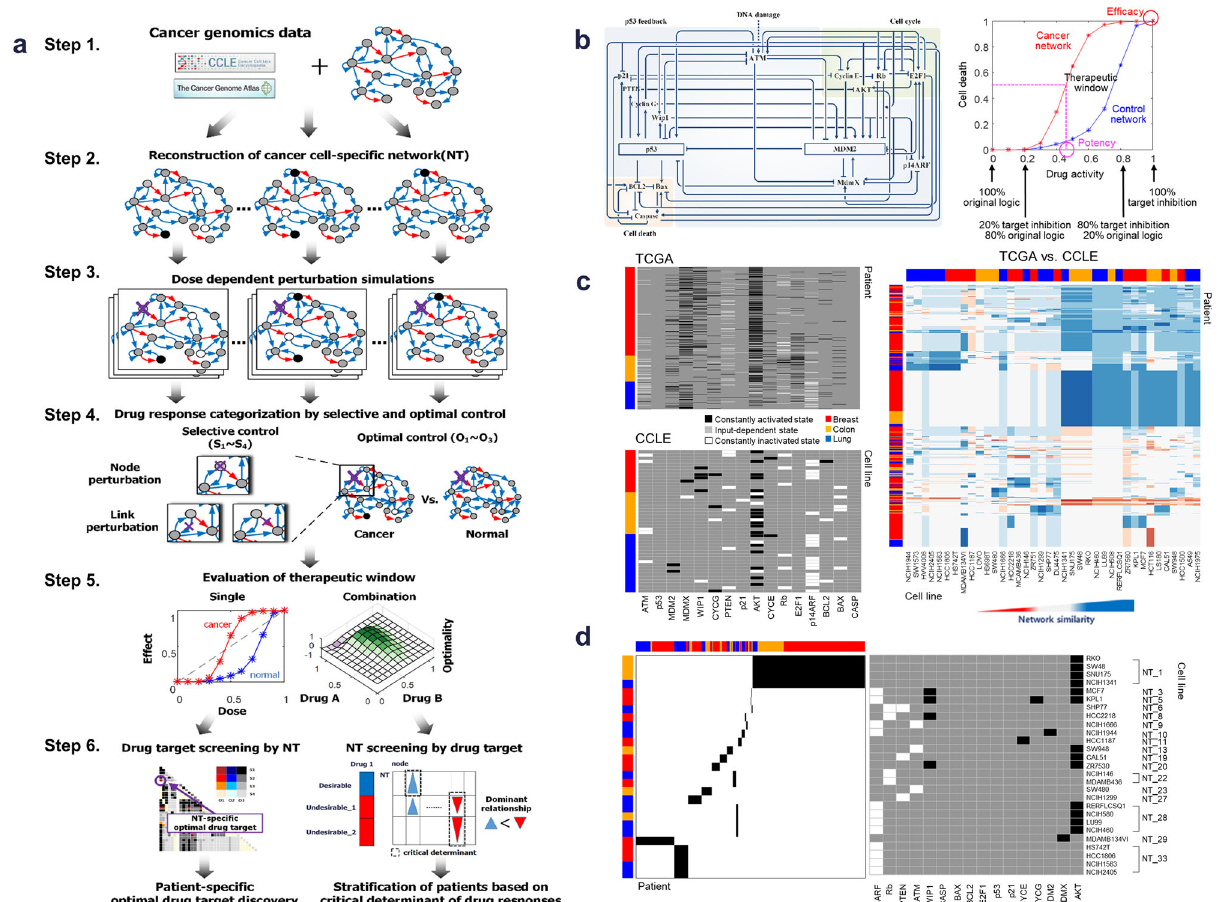
Fig. 1 Network dynamics-based estimation of therapeutic window and application to p53 network. a Overview of the 6 steps in application of network dynamics-based estimation of therapeutic window for drug-target discovery and strati fi cation of patients. b Dose – response curves (right) were obtained from simulations of dose-dependent perturbations in the p53 regulatory network (left). Red and blue graphs denote dose – response curves of cancer and control network, respectively. Ef fi cacy and toxicity were calculated by maximum effects of dose – response curves in cancer and control network, respectively. Potency was calculated by IC50 values of dose – response curves. Therapeutic window was calculated by comparing drug response curves from cancer and control networks. c Evaluation cell lines as tumor models by comparison of network features according to genomic alterations from CCLE (cell lines) and TCGA (patient samples). Functional genomic alterations were projected onto the nominal p53 network. Node status of the p53 network was determined based on the genomic data, and assigned in a ternary fashion, such that node activity is either constantly activated (black), constantly inactivated (white), or input-dependent (gray) (left). A systematic comparison of the networks in the tumors and cell lines is performed to identify cancer cell lines with the highest network similarity to those of cancer patients by determining network similarity through correlation index with values from – 1 to 1 (from red to blue, right). d Selection of cell lines and cancer networks that best match those of patient tumors (left) and genomic alteration pro fi les (right). Cancer cell lines and patient tumors that have the same node activity pro fi le were matched to an identical single